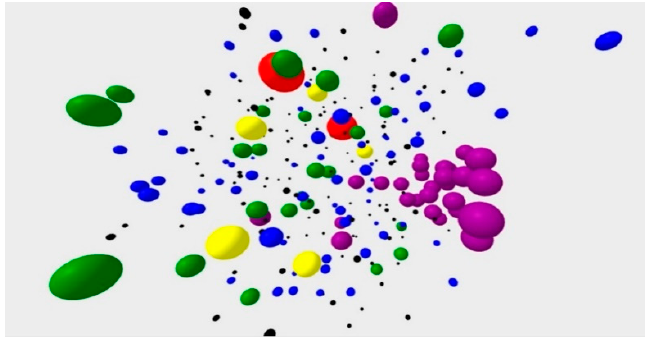
Figure 3. A-Frame technology for 3D visualization. Figure 3 reflects a three-dimensional constellation of terms for